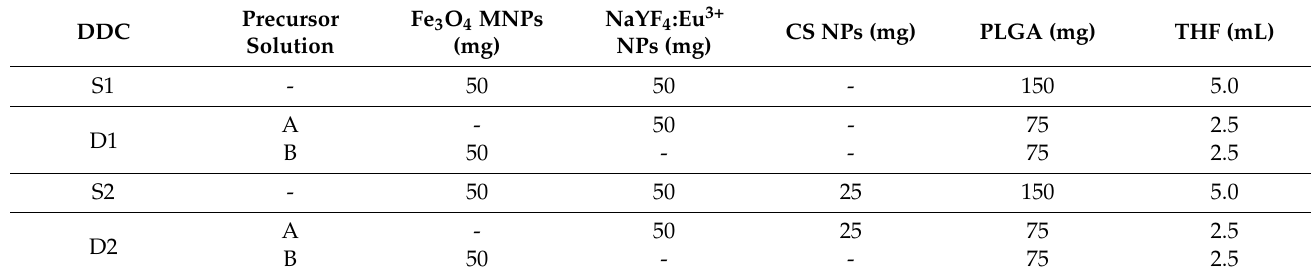
Table 1. Compositions of the precursor solutions for preparing different DDCs.